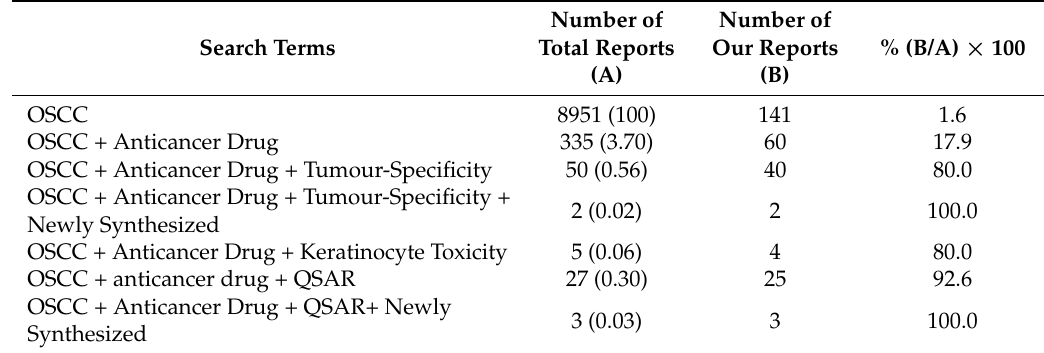
Table 1. Urgency of manufacturing new anticancer drugs with low keratinocyte toxicity (data